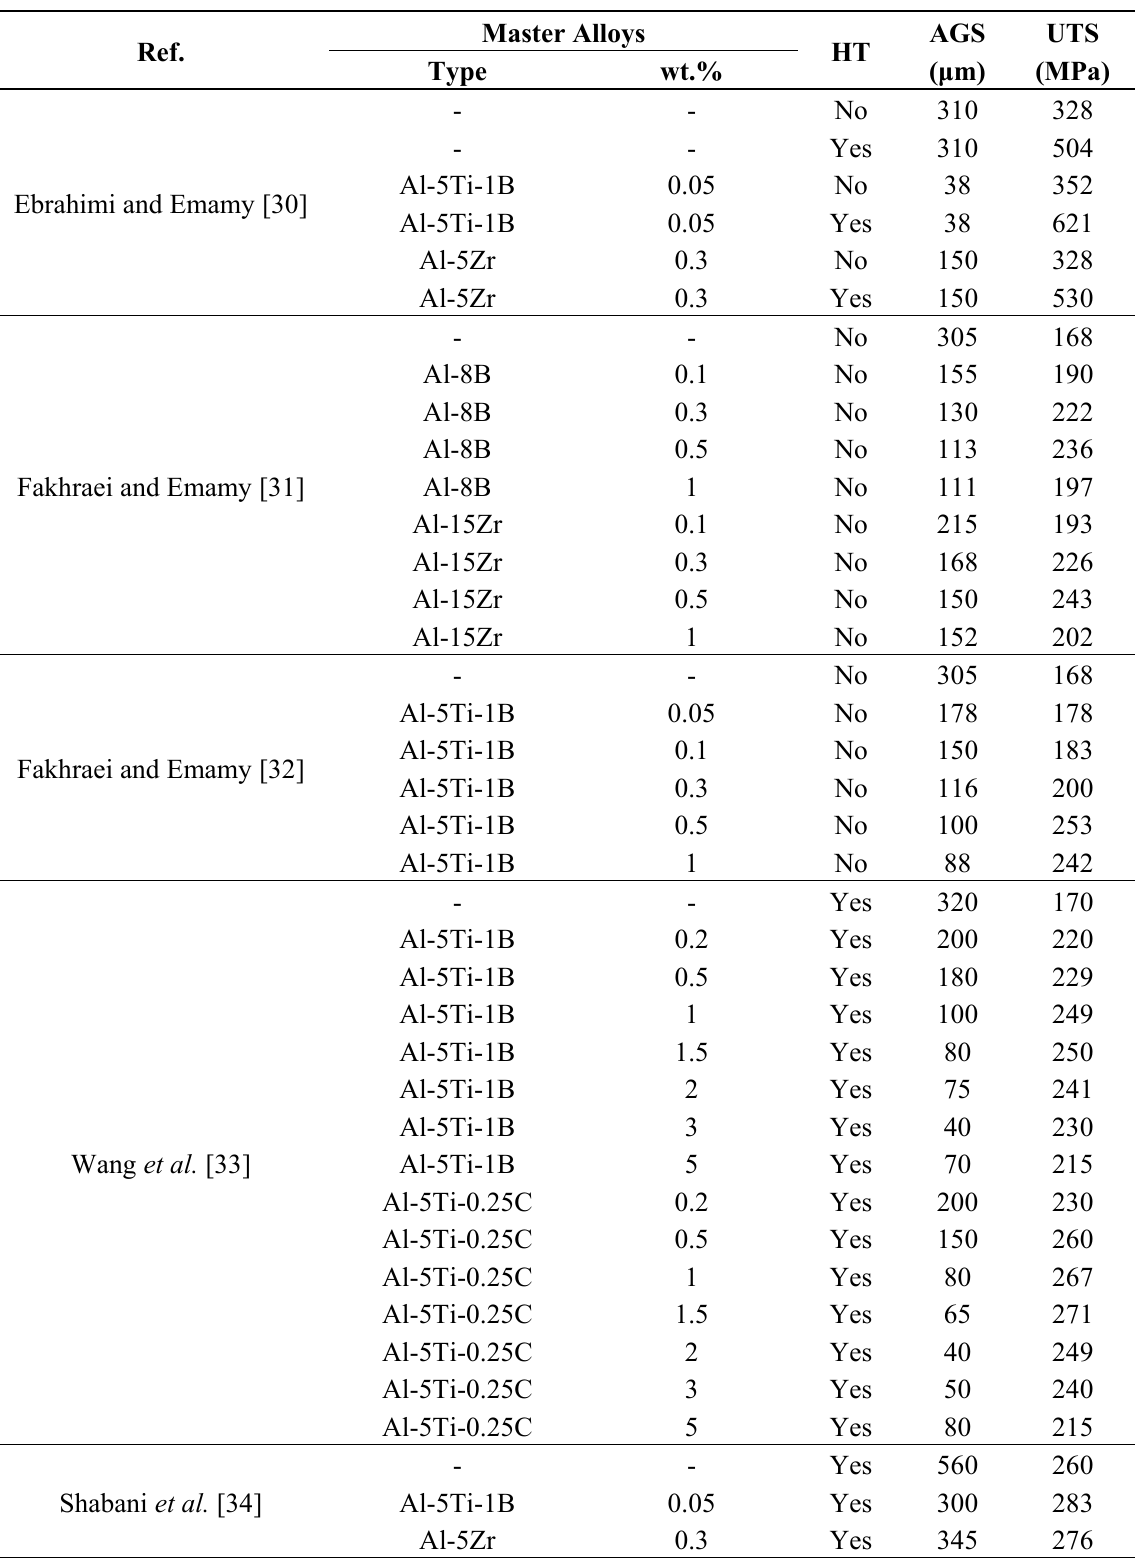
Table 1. Data set for training and